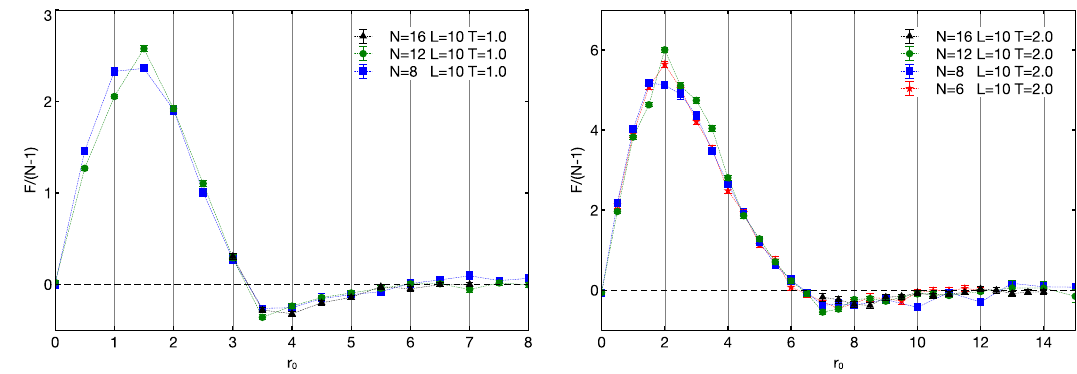
Figure 2 . F ( N; r 0 ) = ( N (cid:0) 1) at T = 1 : 0 and T = 2 : 0. For the largest value of N we only have measurements at large r 0 , beyond the region of the peak.